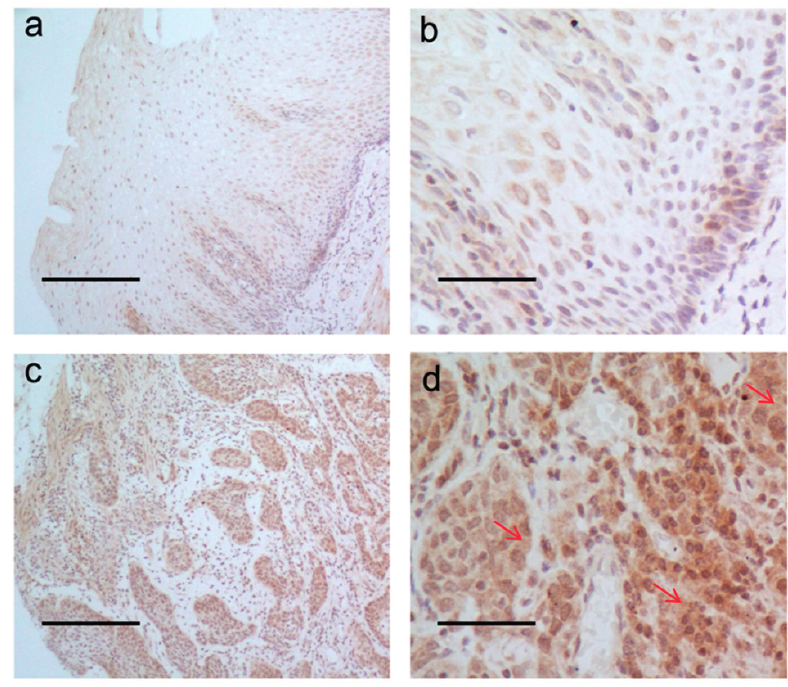
Figure 2. LAMP3 protein expression by IHC assay. ( a , b ) Normal esophageal mucosa showed low expression of LAMP3 protein; ( c , d ) High expression level of LAMP3 was observed in ESCC tissues. ( a , c ) 10×, scale bars: 200 μ m; ( b , d ) 40×, scale bars: 50 μ m. The red arrowheads point out the plasma membrane and cytoplasm area that are stained